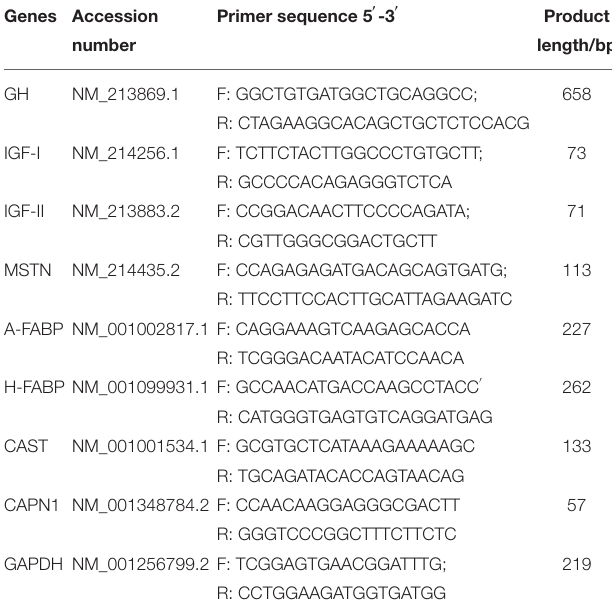
TABLE 2 | Primers for real-time PCR